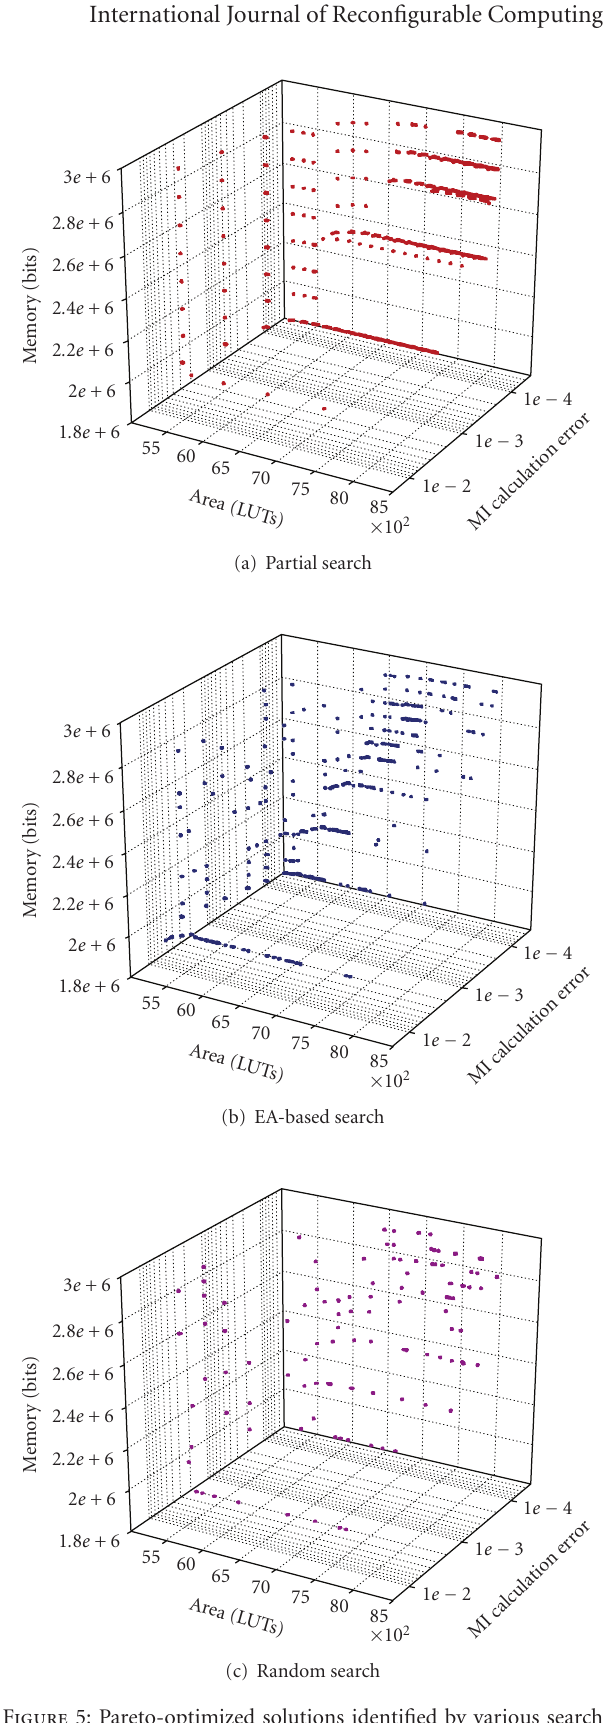
Figure 5: Pareto-optimized solutions identified by various search